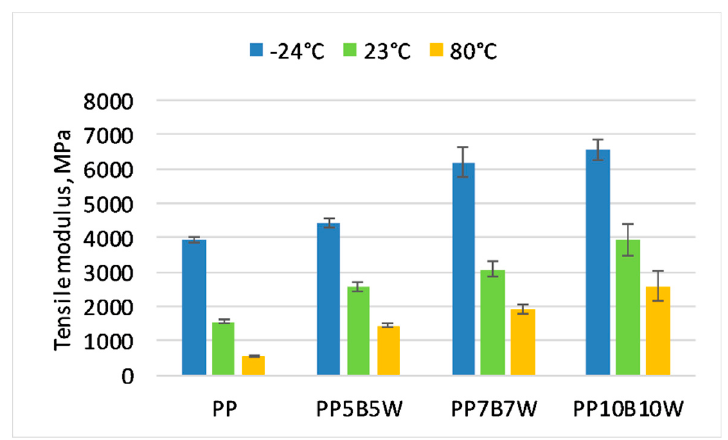
Figure 1. Tensile strength of the tested materials at − 24 °C, 23 °C, and 80 °C.